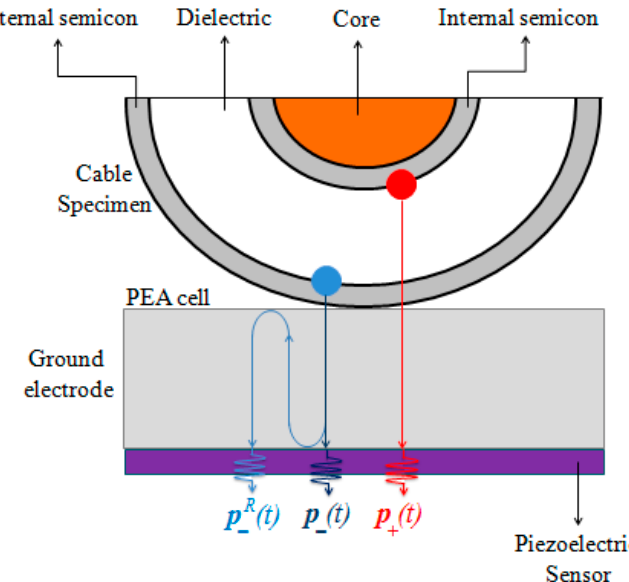
Figure 5. Section of the cable under test and the part of the PEA cell, the latter being responsible of acoustic waves reflection. The paths of the positive and negative waves, both direct and reflected, are reported.